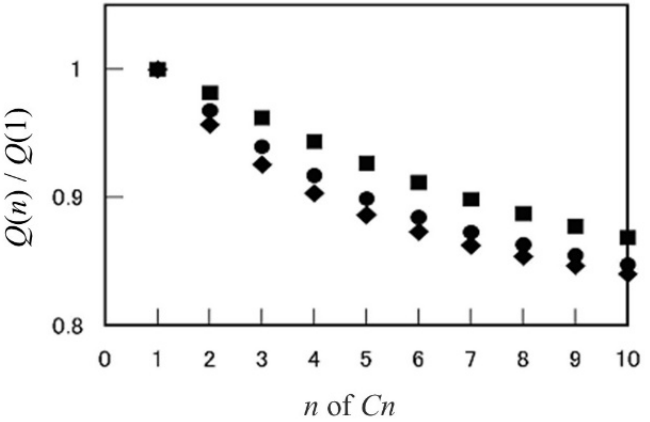
Figure 10. Same as in Figure 9 calculated for aluminum foil with thickness of 5 μ g/cm 2 ( ◆ ), 8 μ g/cm 2 ( ● ), and 15 μ g/cm 2 ( ■ ) [15].